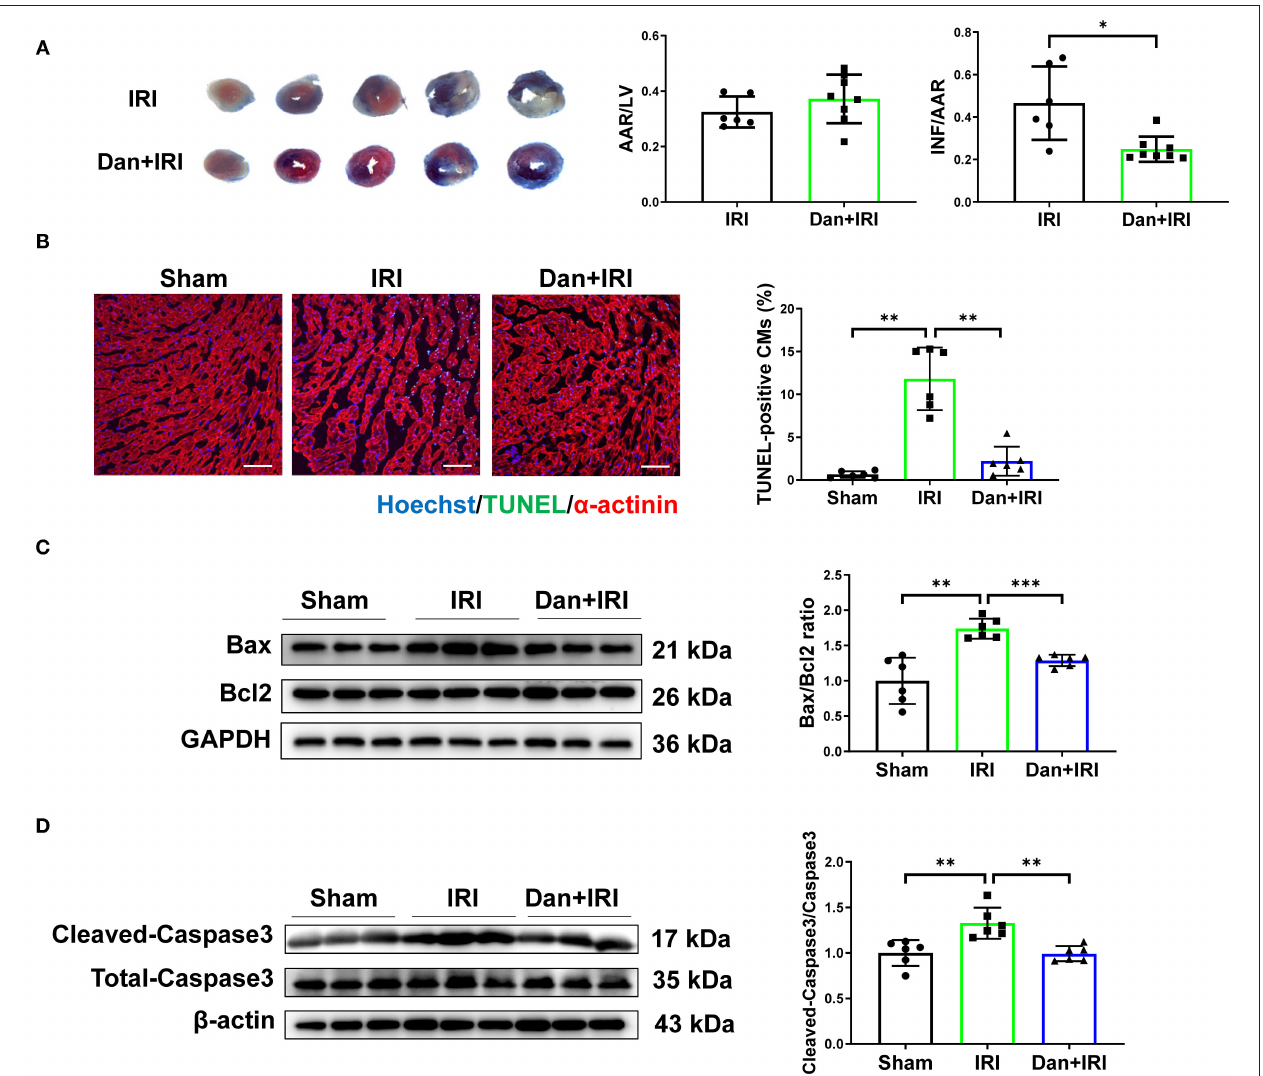
FIGURE 1 | Dan protects mice against acute myocardial ischemia-reperfusion injury in vivo . (A) Adult male mice were administrated by gavage with 700 mg/kg/d of Dan or equal volume of saline for 2 consecutive weeks followed by acute IRI modeling. TTC staining was performed at 24h after IRI. The ratio of AAR/LV was determined for the homogeneity of modeling, and the ratio of infarct area/area at risk (INF/AAR) was determined for the infarct size ( n = 6 vs. 8). (B) Representative images and quantification results of TUNEL/ α -actinin staining were shown for myocardial apoptosis of mice ( n = 6). Scale bar = 100 µ m. (C,D) Western blot analysis for apoptotic-associated proteins in heart tissues, including Bax and Bcl2 (C) and cleaved-caspase 3 and total caspase 3 (D) ( n = 6). * p < 0.05; ** p < 0.01; *** p <